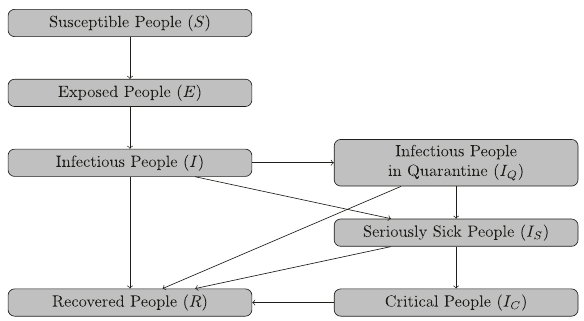
Fig. 4 Flowchart of the states of agents. The possible states of the agents during their process from susceptible ( S ) to recovered people ( R ) are